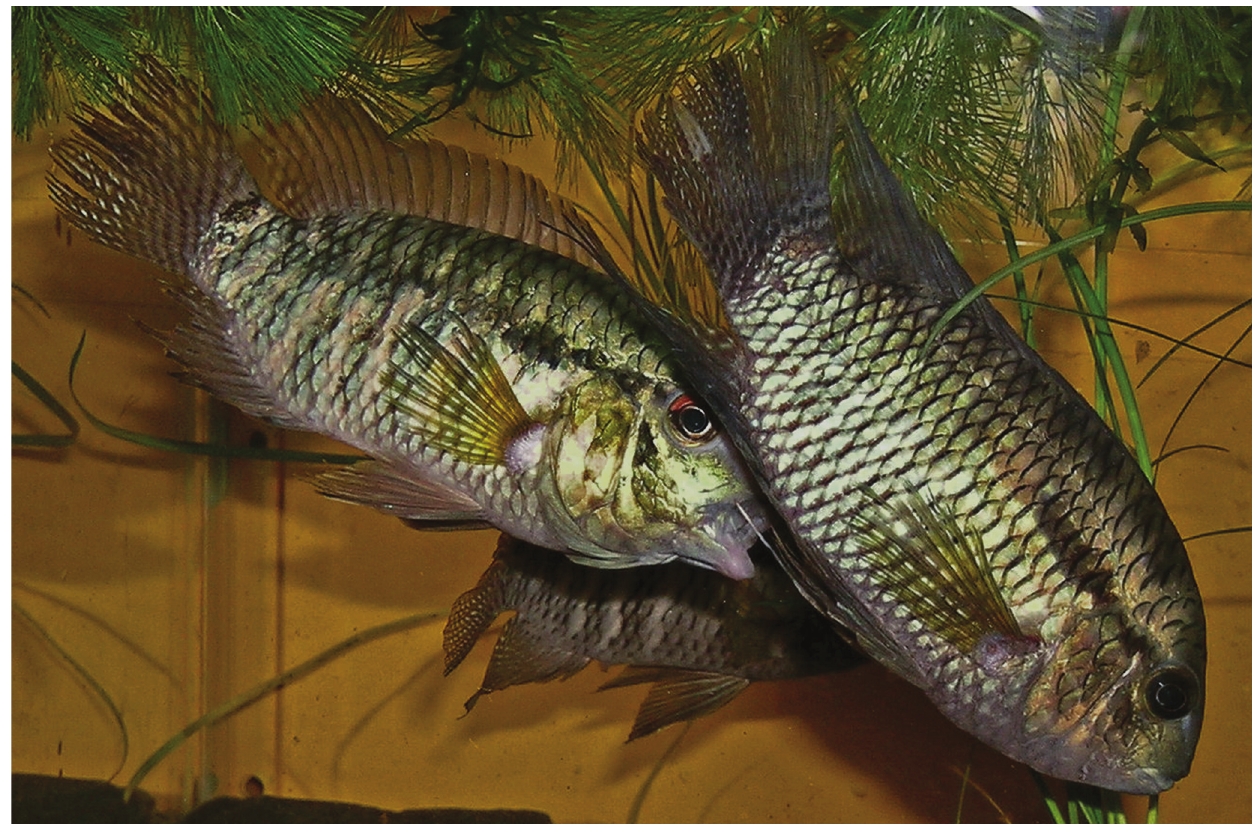
Fig. 5. Reproductive territorial male attacking a non reproductive territorial